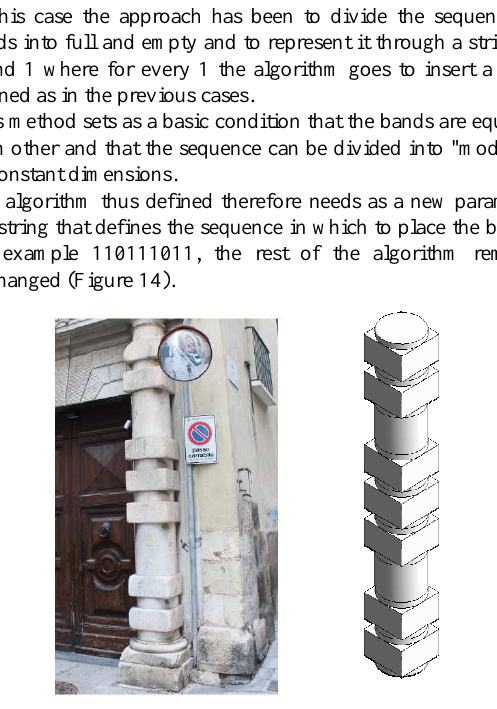
Figure 14. Irregular bands sequence by strings in Palazzo Brondo (Cagliari)